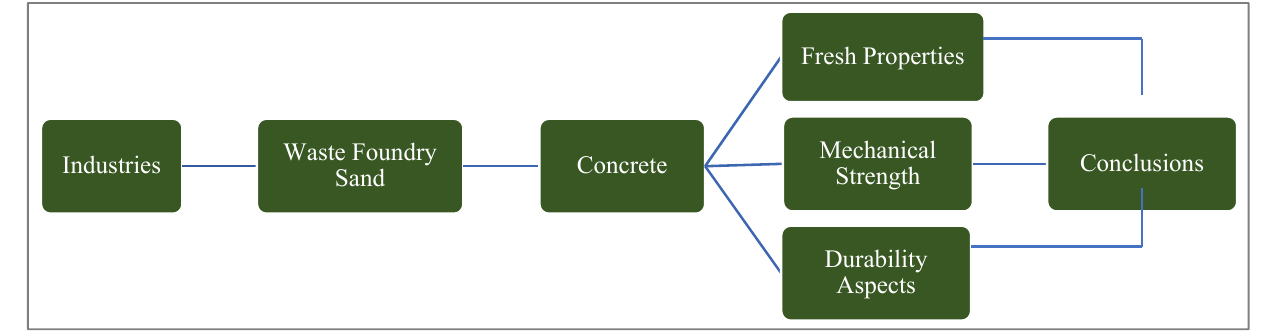
Figure 1. Flow chart.